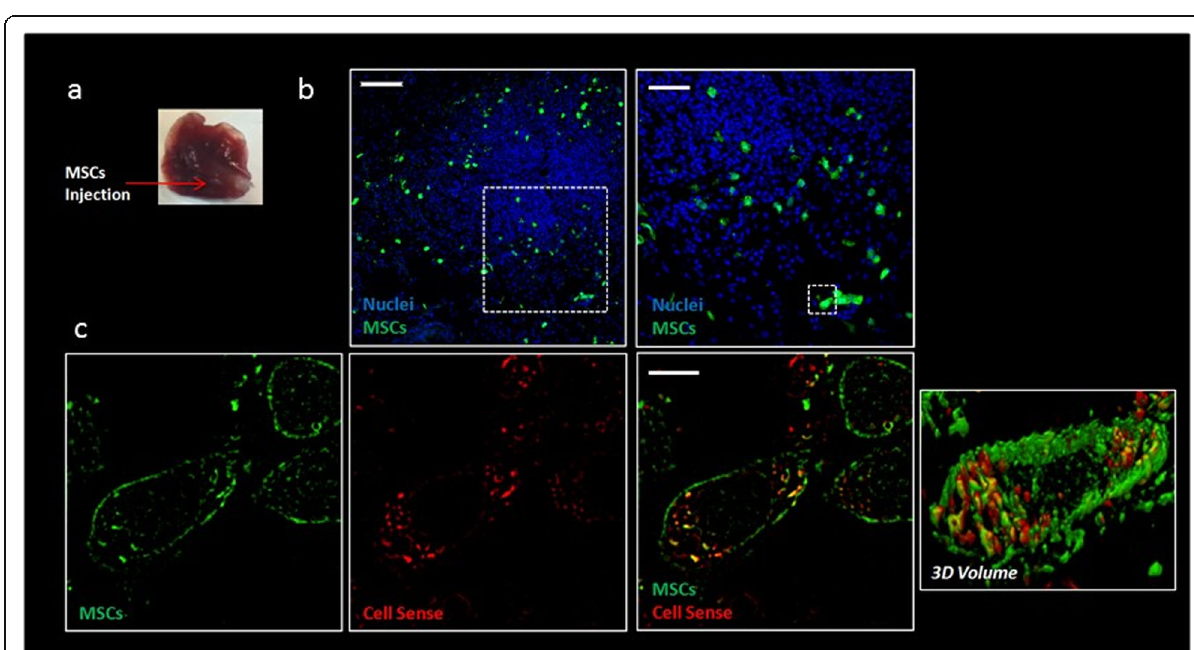
Fig. 5 Detection of green fluorescence protein (GFP) mesenchymal stromal cells (MSCs) labelled with Cell Sense Red in the cranial lobe of rat lung at T 48 . a Image of right cranial lobe of rat lung and indicative direction of MSC injection. b Confocal fluorescence image of right cranial lobe injected with Cell Sense – labelled GFP-MSCs (20× objective, scale bar 100 μ m) and zoom on a restricted area (40× objective, scale bar 50 μ m). The lung was counterstained with 4 ′ ,6-diamidino-2-phenylindole (nuclei). c Representative detailed zoom on GFP (green) and Cell Sense – labelled (red) MSCs through structured illumination microscopy (single-plan image) and three-dimensional volume of 4 μ m z -stack of single Cell Sense-MSC (scale bar 5 μ